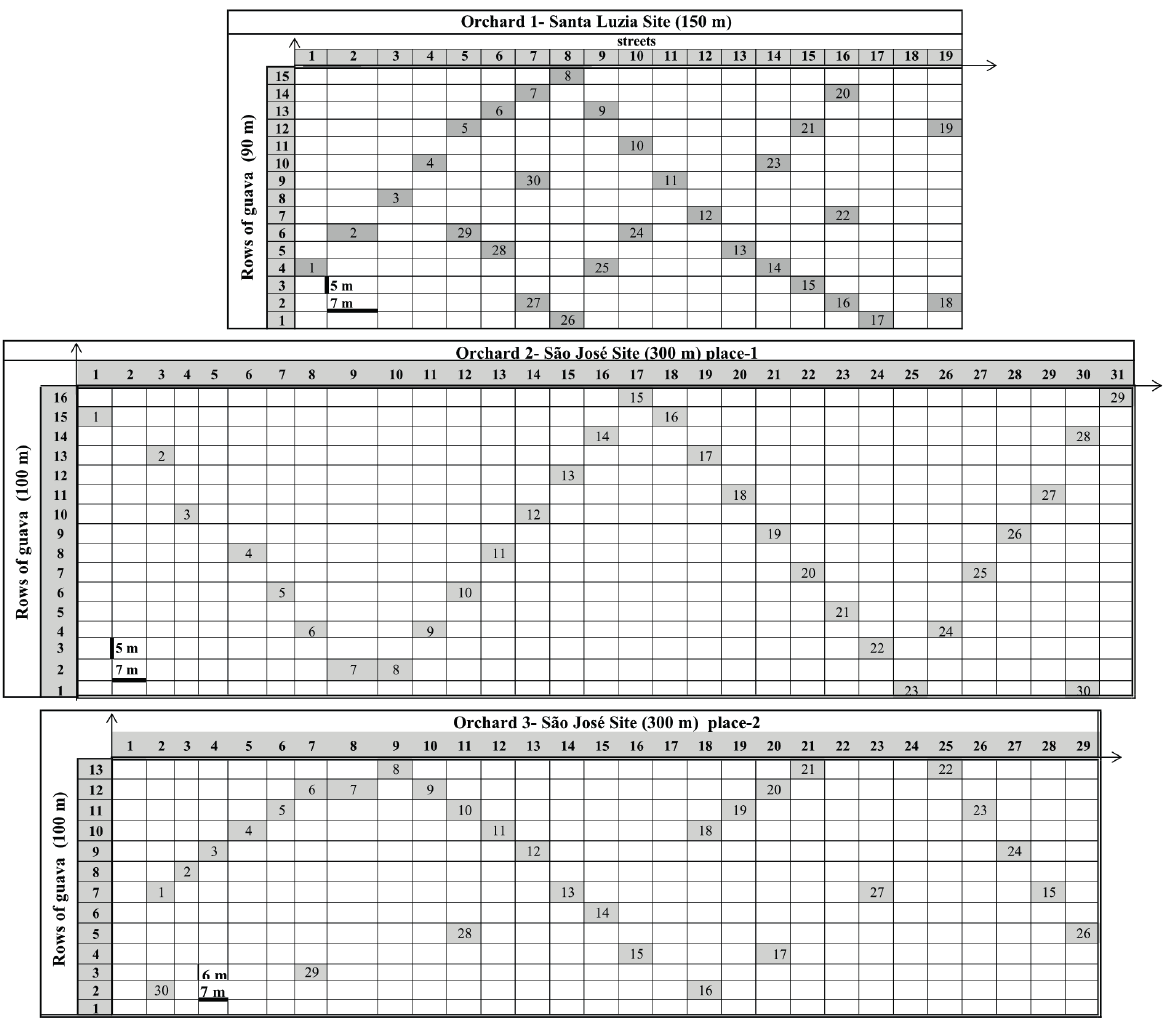
Figure 1 - Commercial guava orchard at three sites, the numbers within of the frames correspond to the sample units (guavas feet) with McPhail traps in the municipality of Ivinhema, Mato Grosso do Sul, between August 2013 and January